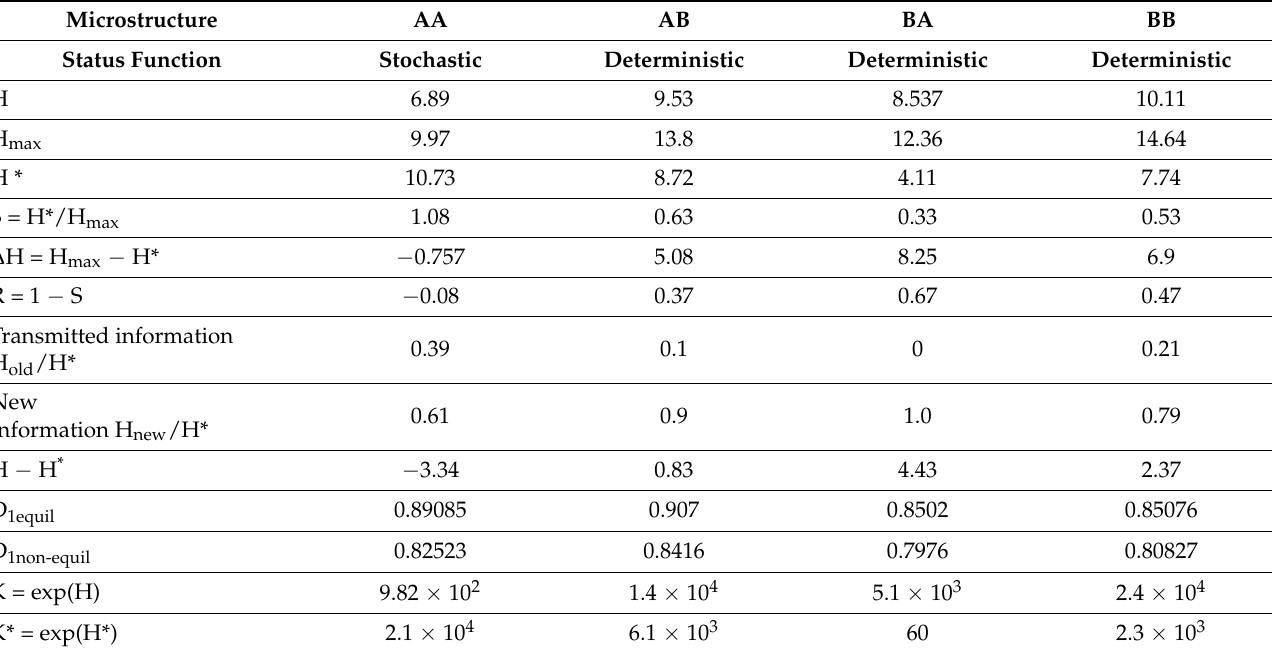
Figure 4. Results of the multifractal analysis of electron microscopic image of the modified sample microstructure: the effect of the d scale on the information entropy of D1 and ∆D. Table 2. Entropy parameters of the modified sample microstructure.